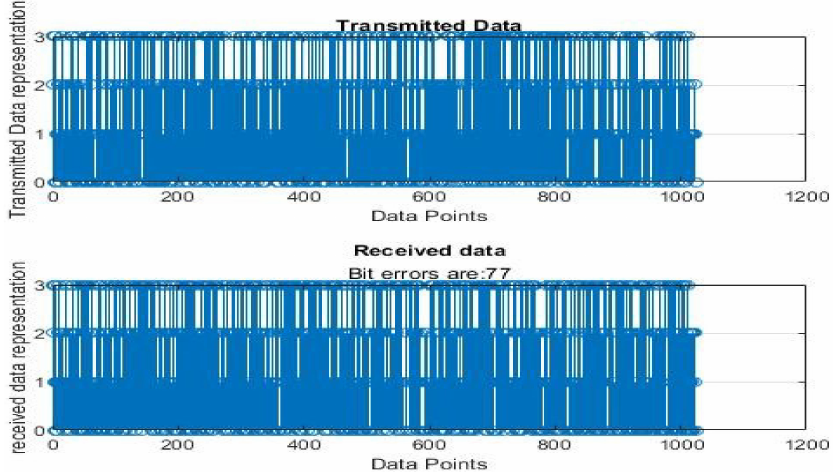
Figure 14. GAWDO QPSK output for 1024 data points in a noisy